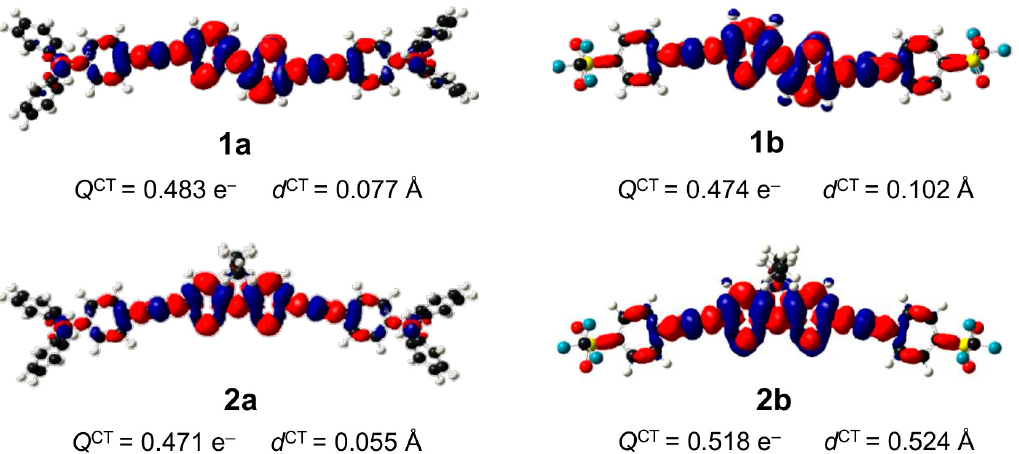
Figure 7. Change in total density (computed at the CAM-B3LYP/6-31 + G(d) level in toluene) upon excitation from the ground state S 0 to the vertical S 1 excited state for 1a , b and 2a , b . The red and blue colors indicate an increase and a decrease of electron density, respectively (contour isodensity value: 0.0002 e/bohr 3 ). Q CT and d CT are the amount of transferred charge and the distance between the centroids of the positive and negative charges, respectively.